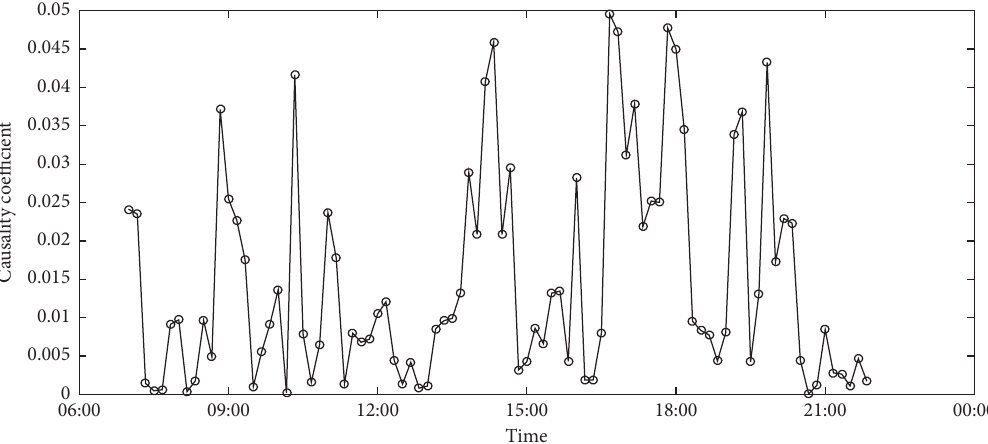
Figure 8: Variation of traffic causality